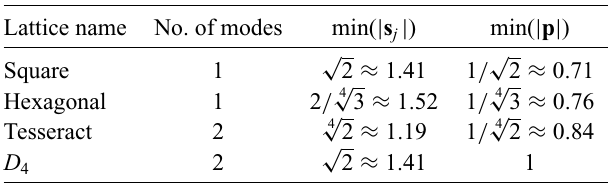
TABLE IV. Examples of qubit codes based on common lat-